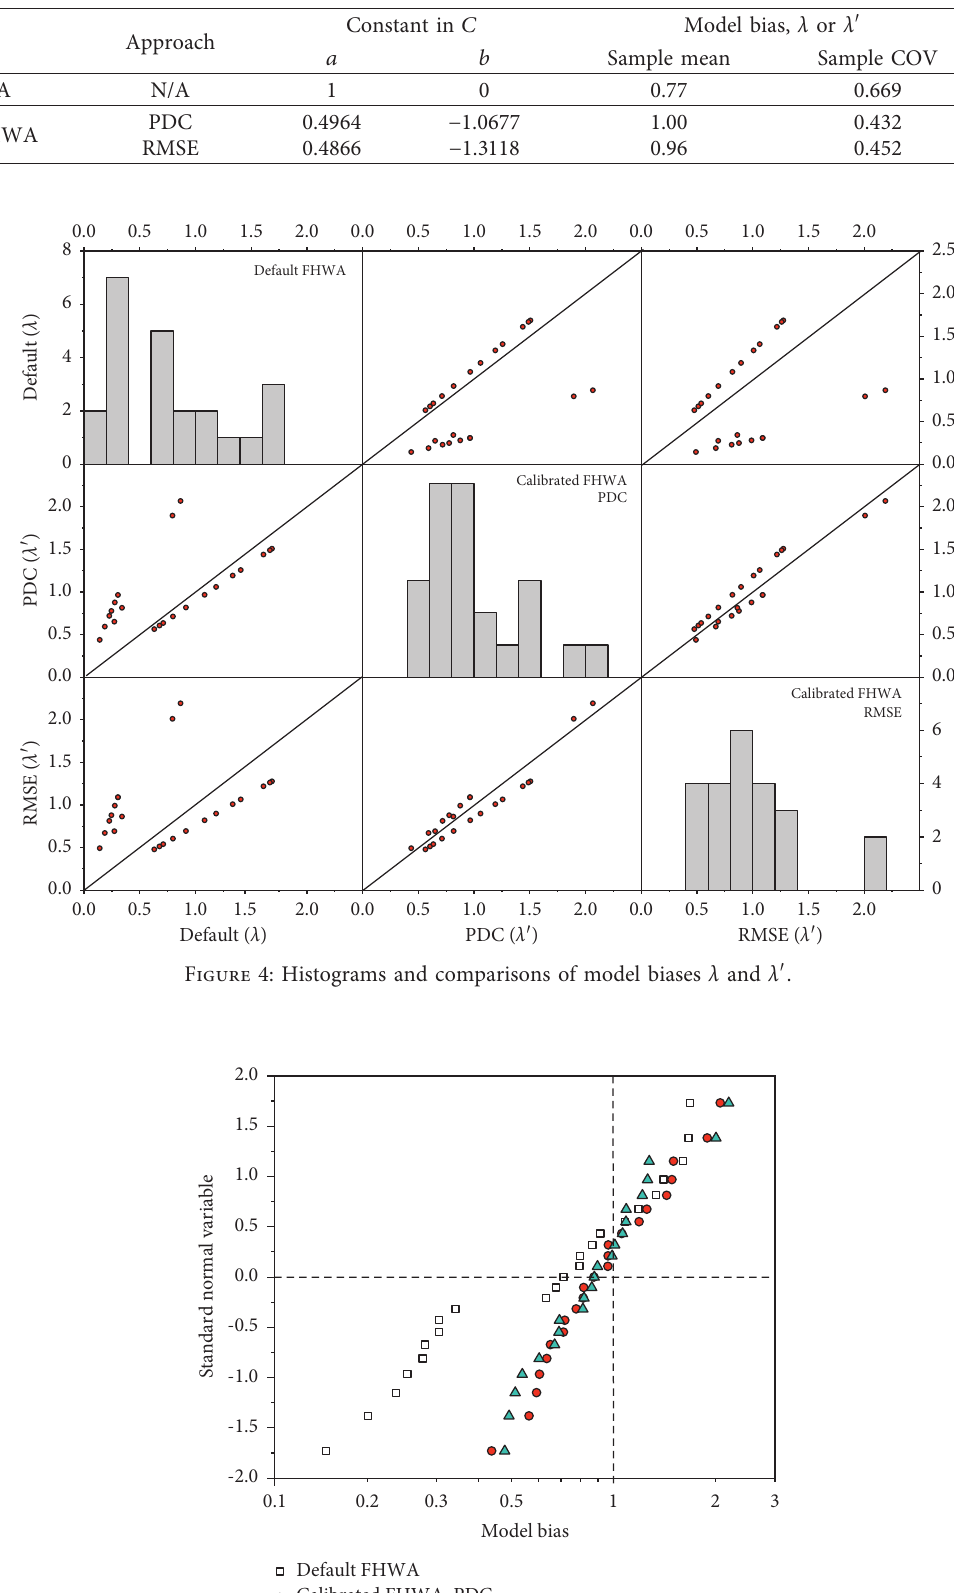
Table 3: Summary of calibration outcomes of equation (10) using the PDC and RMSE approaches.